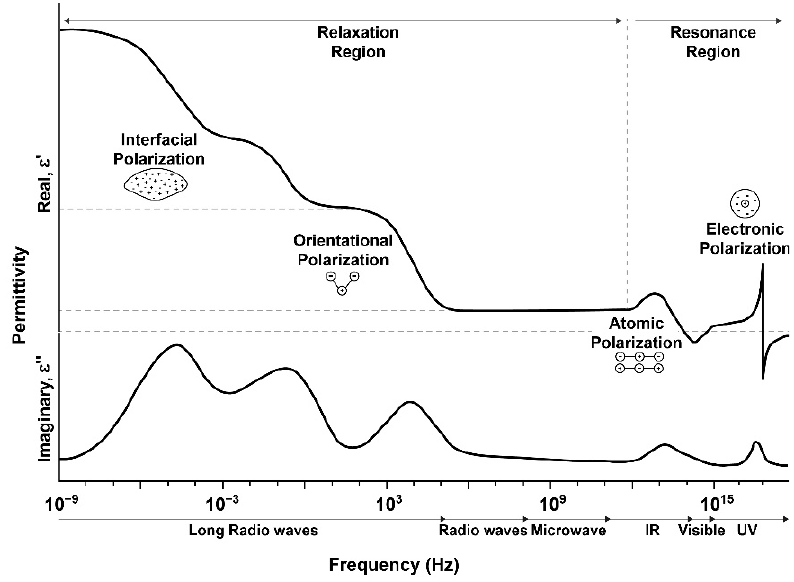
Figure 2. Different kinds of dielectric polarizations over broadband frequency range.